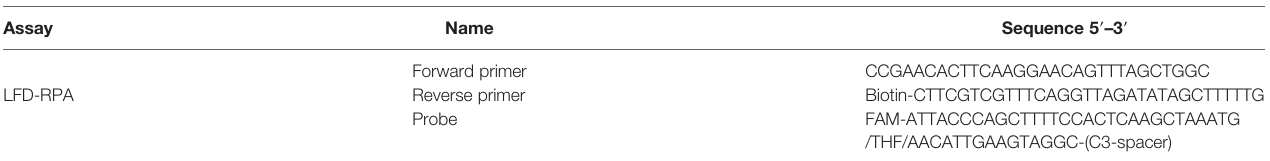
TABLE 1 | Sequences of primers and probe used in the LFD-RPA assay.